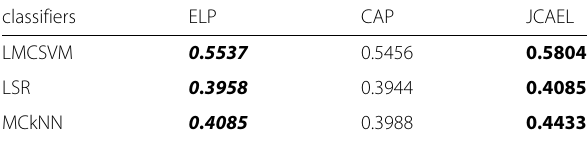
Table 6 Comparisons of feature selection algorithms on UCF ← PPMI4 in terms of average accuracy using three classifiers when the ratio of labeled video data are set to 5%